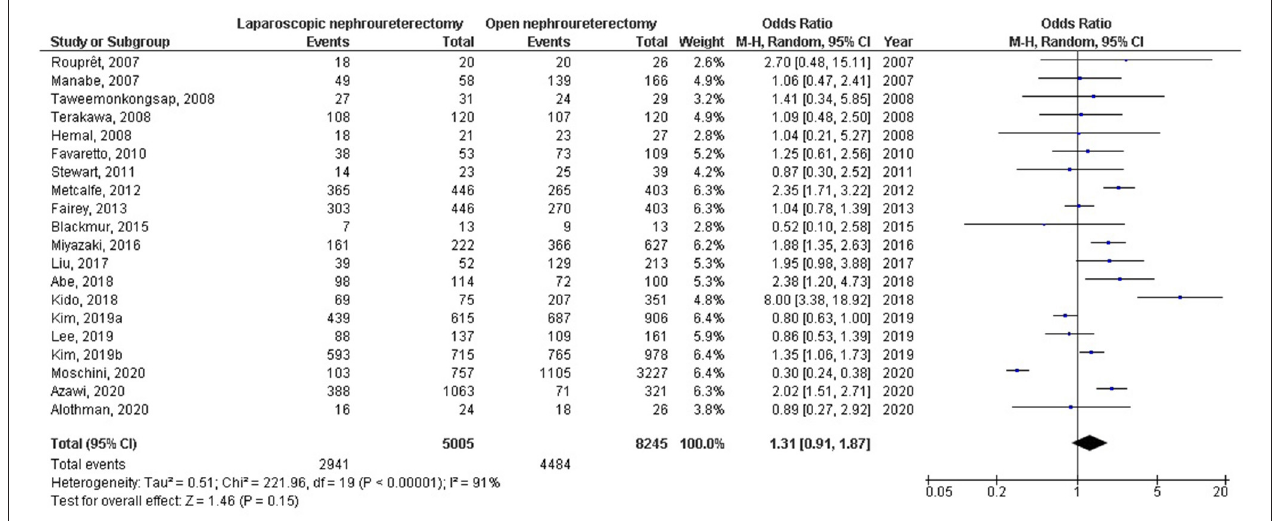
FIGURE 2 | Forest plot of the effect of open nephroureterectomy compared with laparoscopic nephroureterectomy on operation time in subjects with upper urinary tract urothelial carcinoma.